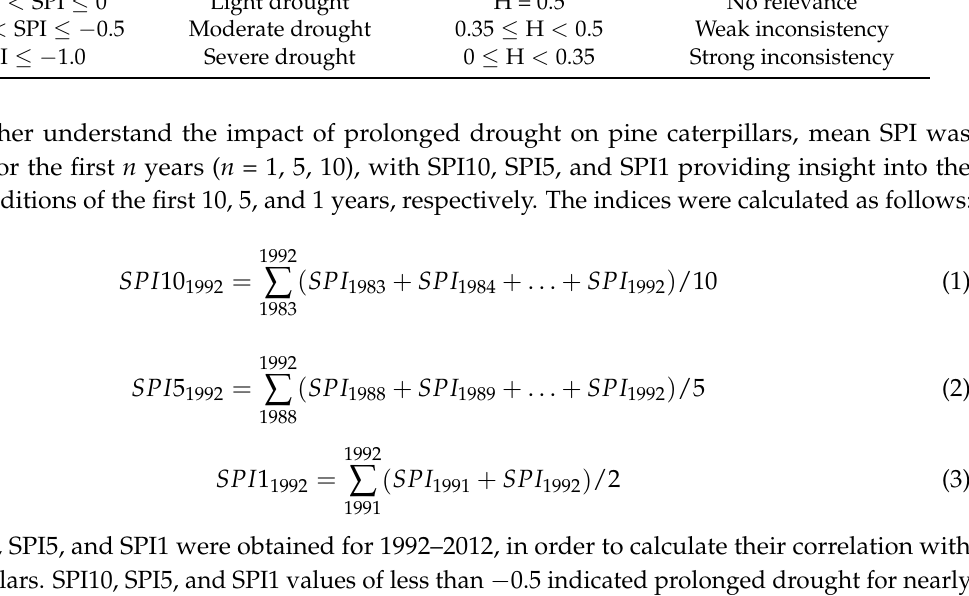
Table 1. Classification used for the Standard Precipitation Index (SPI) and Hurst exponent (H). SPI Drought Class H Consistency 0.5 < SPI ≤ 1 Moderate wet 0.65 < H ≤ 1 Strong consistency 0 < SPI ≤ 0.5 Normal 0.5 < H ≤ 0.65 Weak consistency − 0.5 < SPI ≤ 0 Light drought H = 0.5 No relevance − 1.0 < SPI ≤ − 0.5 Moderate drought 0.35 ≤ H < 0.5 Weak inconsistency SPI ≤ − 1.0 Severe drought 0 ≤ H < 0.35 Strong